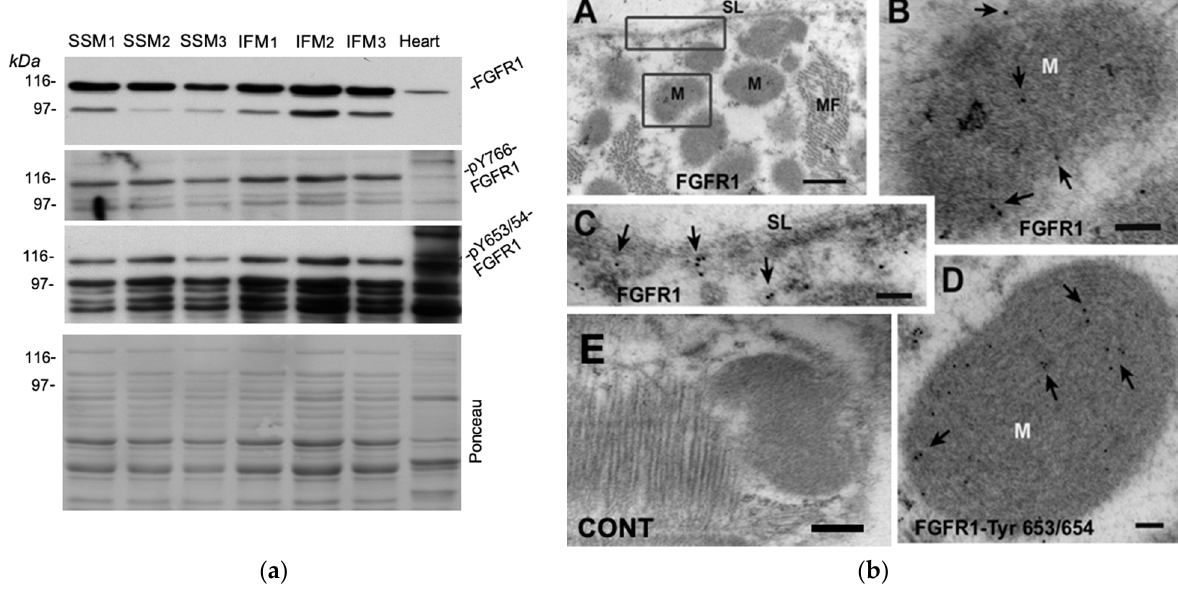
Figure 2. Immunoreactive FGFR1 is present in cardiac mitochondria: ( a ) Western blots of subsarcolemmal (SSM; n = 3) and interfibrillar (IFM; n = 3) preparations probed for total FGFR1 (QED A/B), pY766-FGFR1 (sc-16309-R), and pY653/654-FGFR1 (sc-30262), as indicated, respectively by -FGFR1, -pY766-FGFR1, -pY653/654-FGFR1. Immunoreactive FGFR1 is detected in SSM and IFM preparations; ( b ) immunogold labelling for FGFR1 in cardiomyocytes in situ. Picture A represents a lower magnification of an ultrathin section processed for anti-FGFR1 staining; affinity-purified rabbit anti-FGFR1, #F5421. Boxed areas corresponding to mitochondria (M) and sarcolemma (SL) are shown as higher magnifications in pictures B and C, respectively. Picture D shows cardiac mitochondrial staining by anti-pY653/54-FGFR1, #sc-30262-R. Picture E represents a control (CONT) section where primary anti-FGFR1antibody was omitted but was incubated with gold-labelled secondary antibodies. MF = myofilaments. Scale bars: A, 500 nm: B − E = 100 nm.